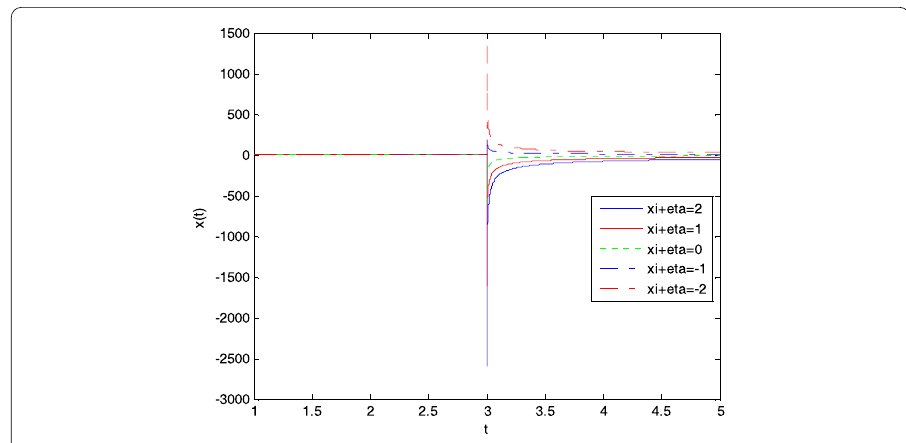
Figure 9 The solution trajectory of system (5.3) with ρ = 0.1